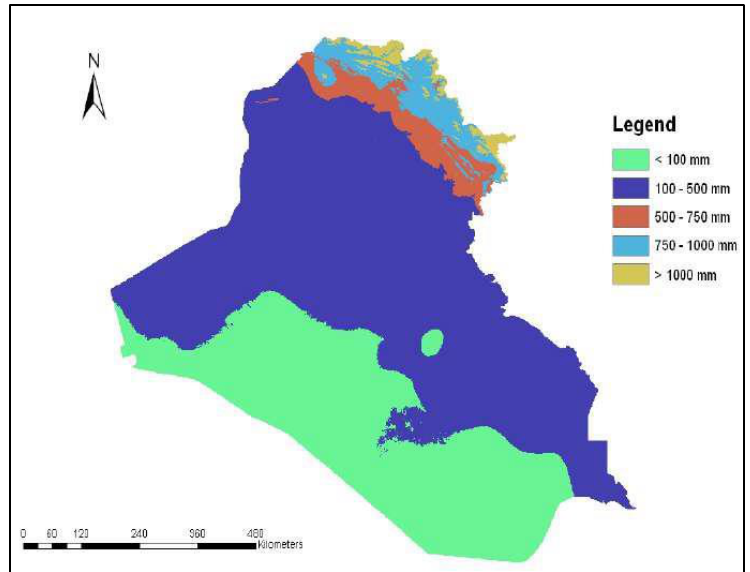
Figure 4. Annual rainfall map of Iraq [41] .